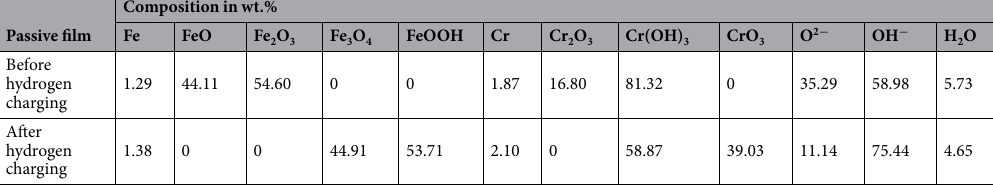
Table 1. The elemental composition of the passive film formed on duplex stainless steel before and after hydrogen charging.